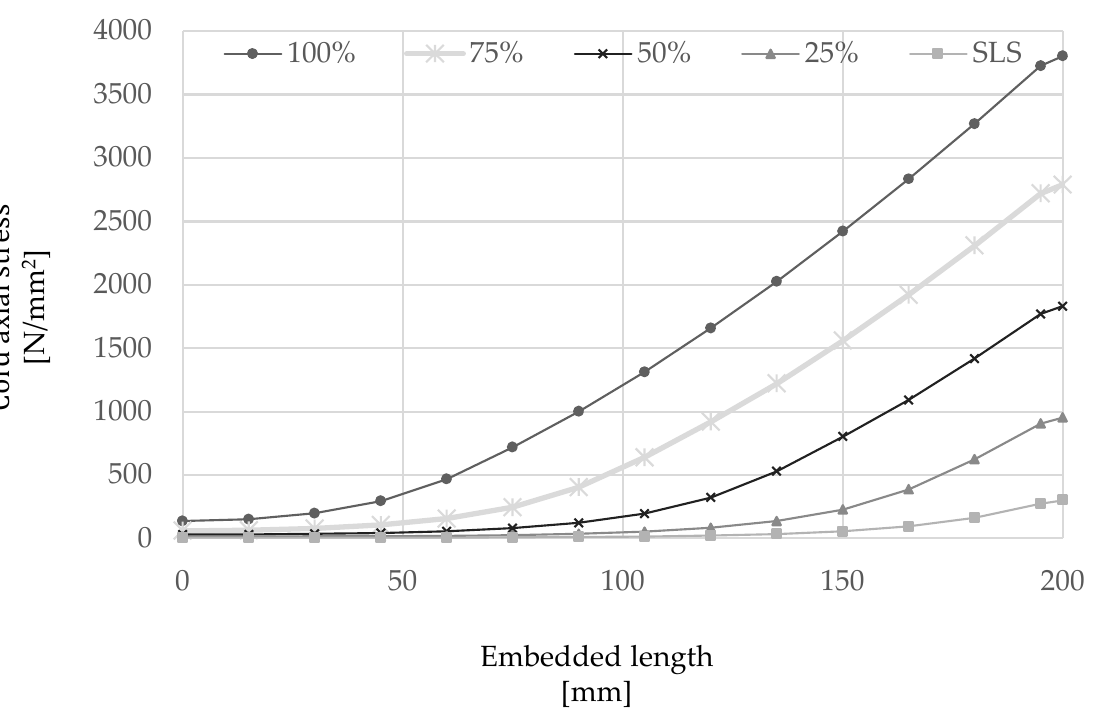
Figure 16. Distribution of axial stress in the mortar along the embedded length of 200 mm at several load levels. 6. Conclusions The main aim of this study was to examine experimentally the bond behavior of in- dividual cords embedded in a mortar matrix and develop a modeling strategy to deter- mine the local τ-slip response through the implementation of an inverse analysis tech- nique. Two different cohesive laws have been identified to describe the behavior of steel cords embedded in a cementitious and a lime-based mortar matrix. The validated model was then used for the case of steel cords embedded in a lime-based mortar to conduct a